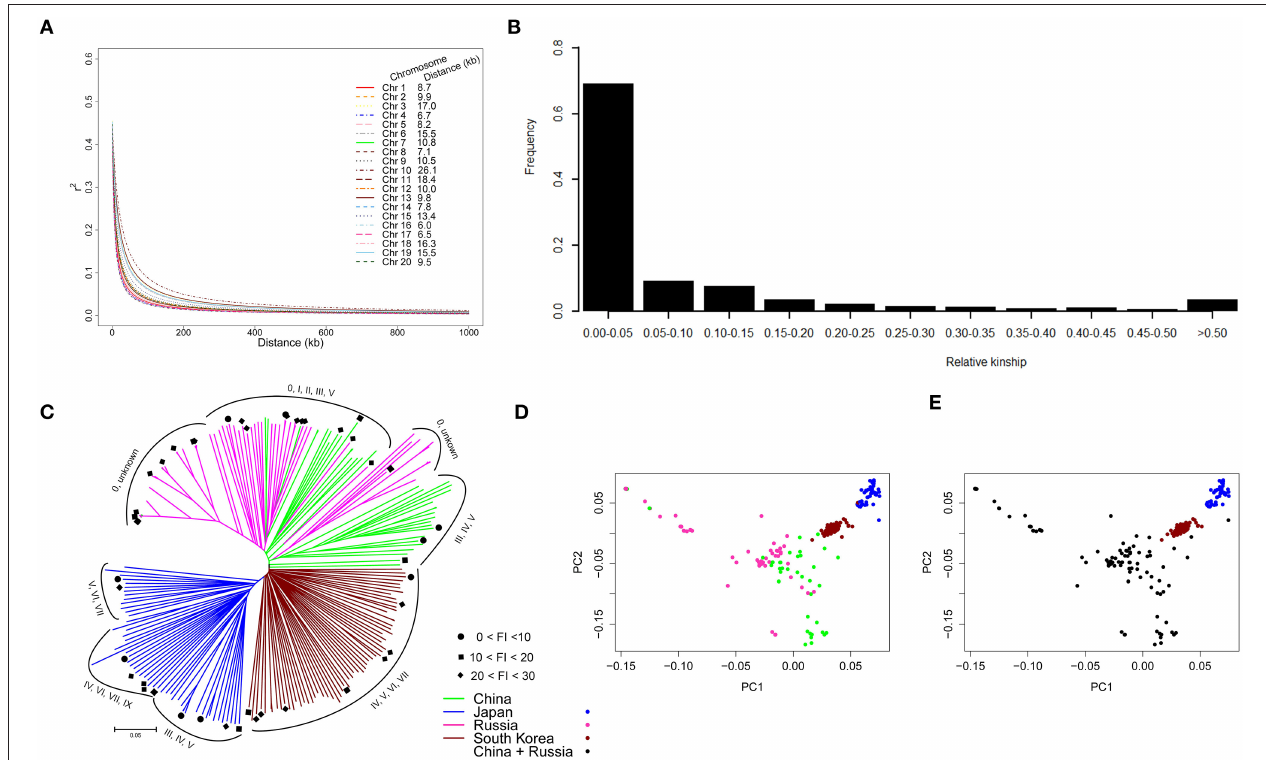
FIGURE 2 | Analysis of LD decay, relative kinship, and estimated population structure. (A) LD decay pattern of SNPs on 20 soybean chromosomes. The distance (kb) of LD decay per chromosome is given beside the legend. (B) Distribution of pairwise kinship for 235 G. soja accessions. (C) Unrooted NJ tree of 235 G. soja accessions. The maturity group (MG) for each accession is labeled with Roman numerals based on the clusters. Resistant and moderately resistant accessions are marked with a solid circle (FI < 10), square (10 < FI < 20), and diamond (20 < FI < 30). (D) Plot of the first two PCs of the panel based on country of origin. (E) Plot of grouping results of the panel based on the first three PCs. The color-coded subpopulations indicated in (C–E) represent the country of